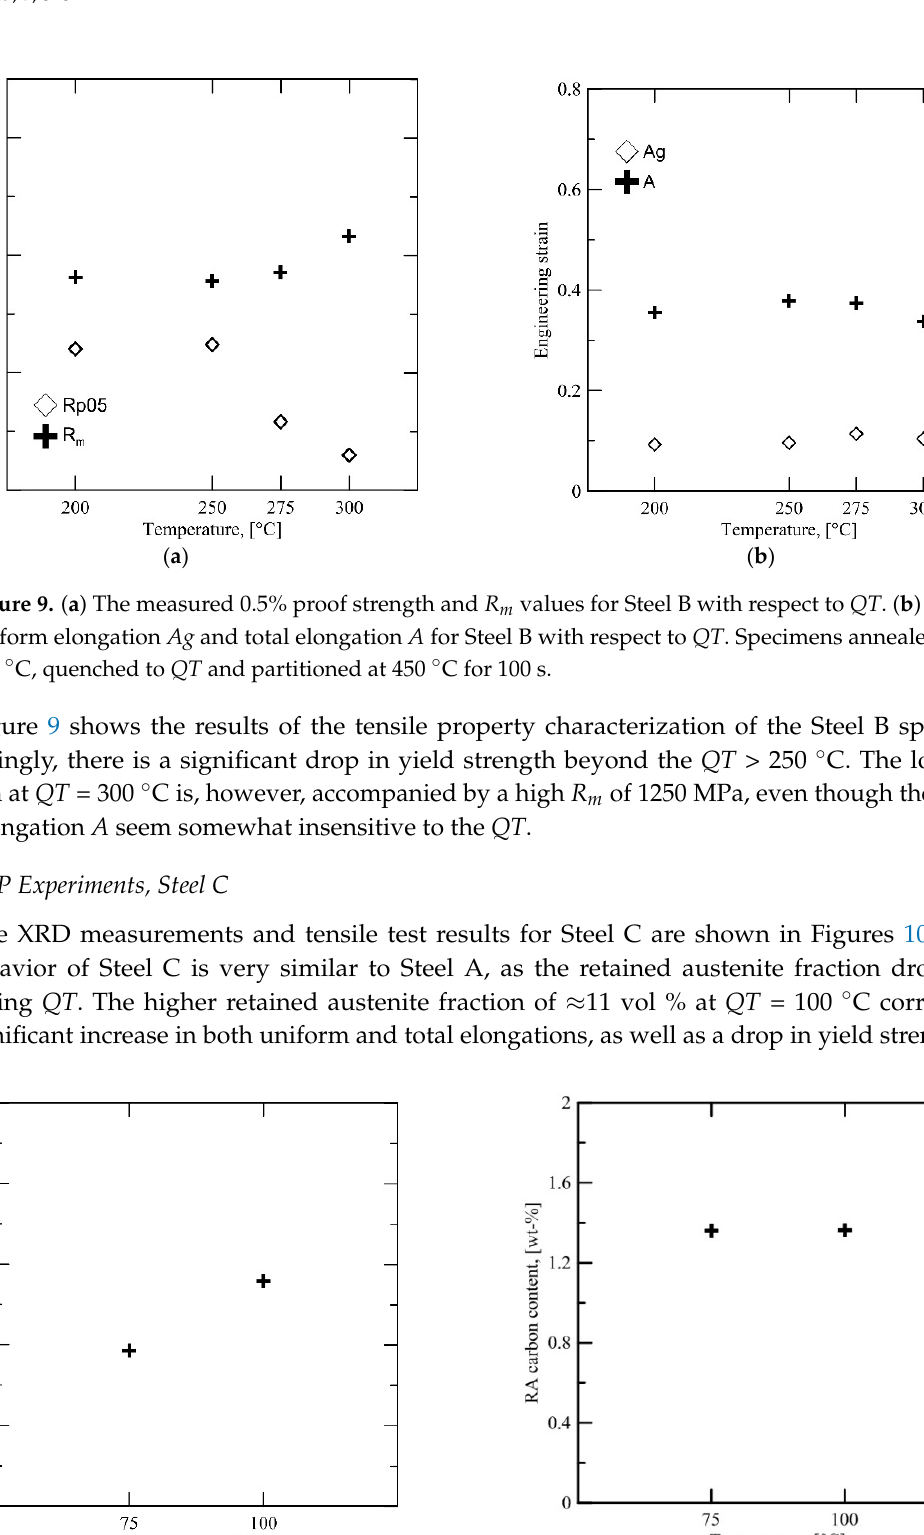
Figure 10. ( a ) The retained austenite fraction of Steel C with respect to initial quench temperature QT . ( b ) The carbon content of the retained austenite with respect to QT . Specimens annealed at 850 °C, quenched to QT and partitioned at 450 °C for 100 s.